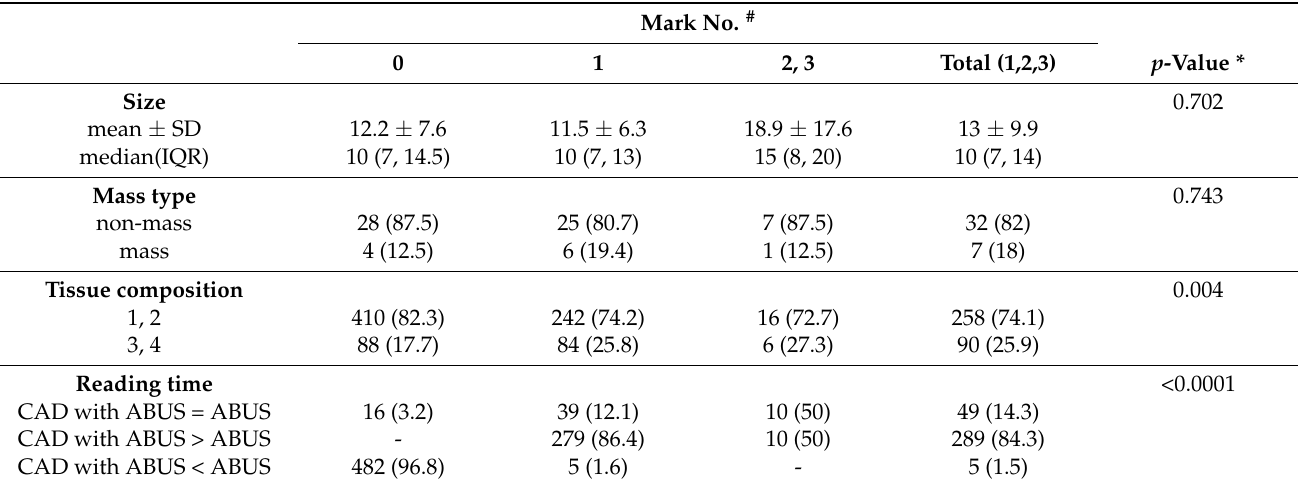
Table 2. Characteristics of number for computer-aided detection (CAD) marks per patient and reading time